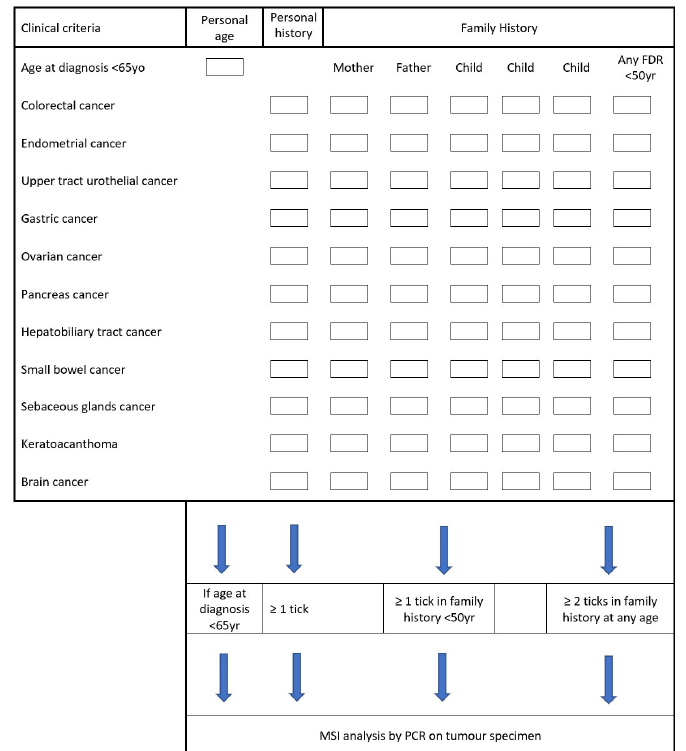
Figure 5. Patient ‐ based checklist to assist the urologist in identifying individuals with upper tract urothelial carcinoma requiring molecular testing for Lynch syndrome. Adapted from the European Association of Urology—Young Academic Urologists and Global Society of Rare Genitourinary Tumours [28].